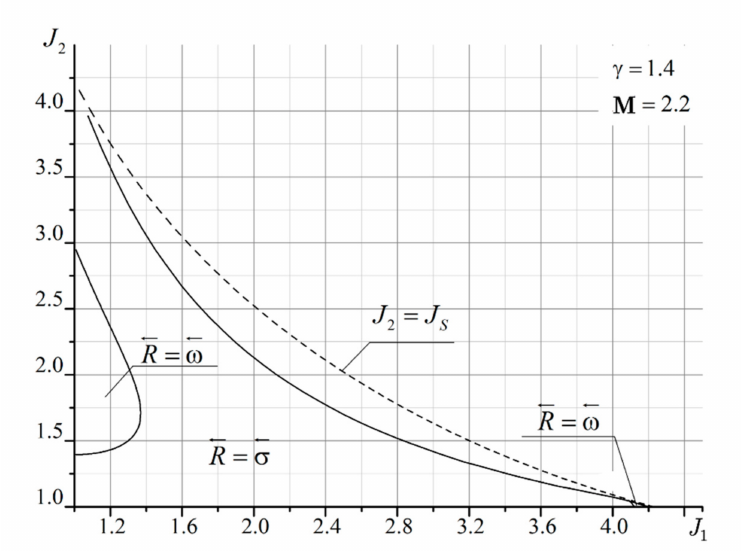
Figure 15. Domains of existence of various types of reflected discontinuity for M = 2.2. Thus, at high Mach numbers, the design of an optimal air intake with two oblique shocks is difficult, and it is necessary to examine other schemes. Figures 16–18 show the values of the intensity of the reflected